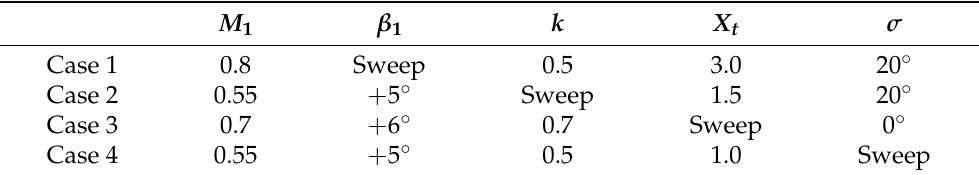
Table 3. Input parameters for ANN sweep